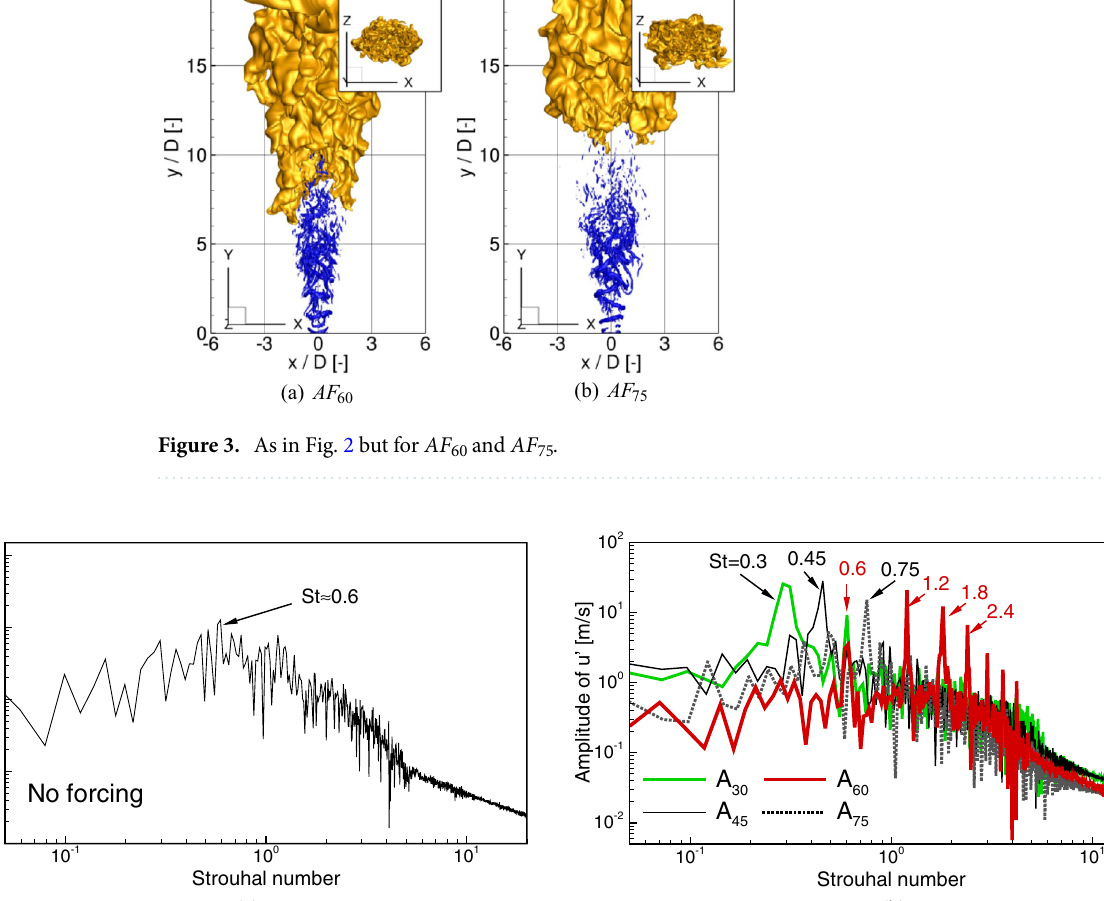
Figure 4. Velocity spectra at y / D